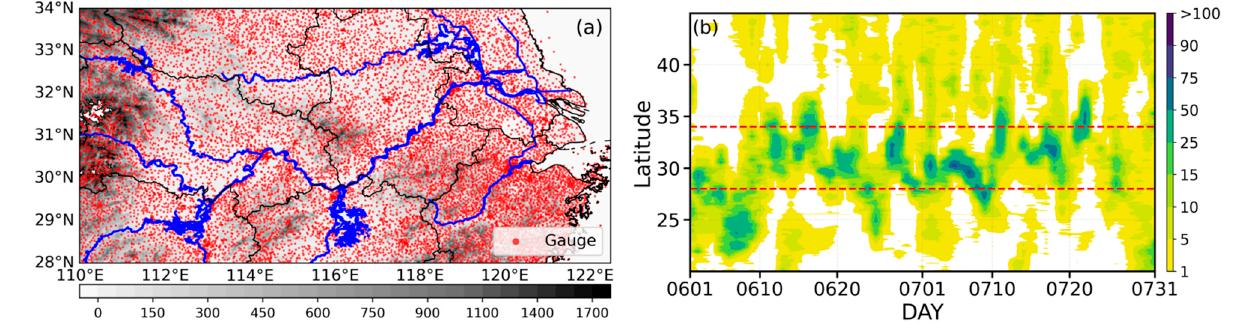
Figure 2. ( a ) Spatial distribution of surface rainfall observation stations in the Meiyu monitoring area (28°–34° N, 110°–122.5° E) and topographic features, in which the red dots denote the rain gauges of automatic weather stations and the filled parts indicate the topographic height (blue line is the main river). ( b ) Time-latitude profile of daily precipitation averaged along 110°–122.5° E during the 2020 Meiyu precipitation period (1 June–31 July), in which the red dashed line represents the north-south boundary of the Meiyu monitoring area.